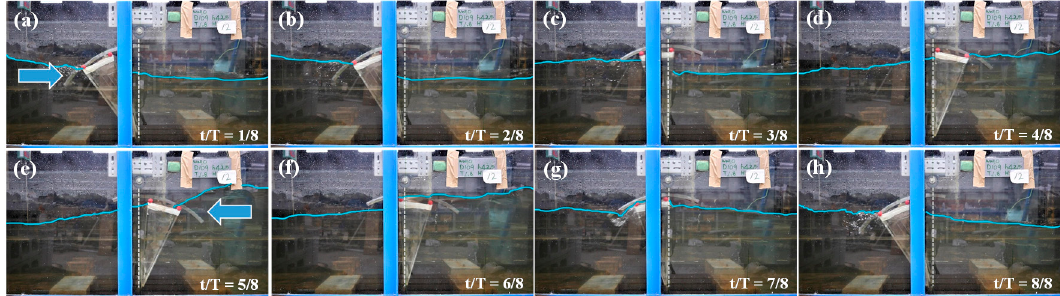
Figure 19. Screenshots of the flap motions for the case of D = 1.09 m, h = 0.425 m, T = 1.8 s, and H i = 0.12 m at ( a ) t / T = 1 / 8 to ( h ) 8 / 8. D / L is 0.3253 and k e = 0.76. The blue arrow denotes the wave direction acting on the flap, and the white dotted line indicates the rotational neutral axis of the flap. The blue solid line denotes the water surface.